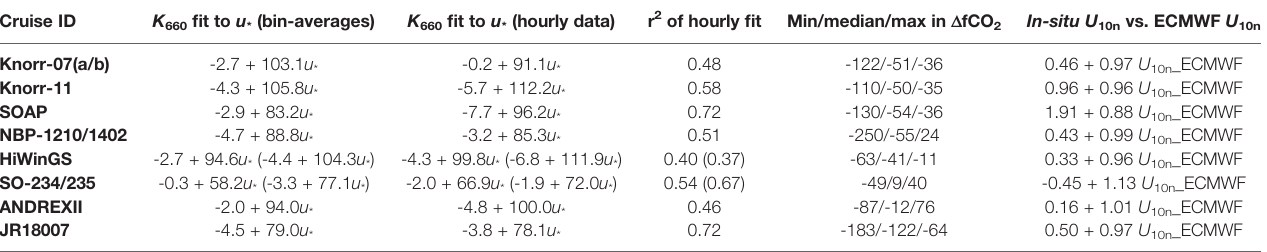
TABLE 2 | Regression analyses between CO 2 K 660 (in cm hr -1 ) and friction velocity (in m s -1 ) between u * values of 0.1 and 0.5 m s -1 . Cruise